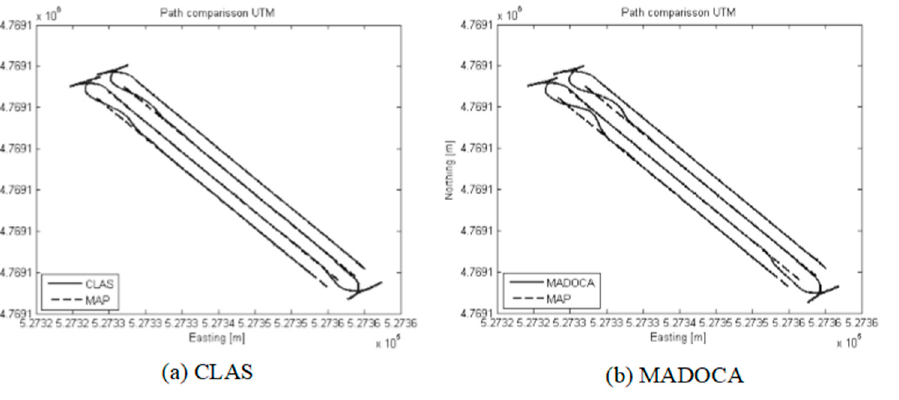
Figure 8. Logged positioning data of the robot combine harvester ( a ) CLAS, ( b ) MADOCA .